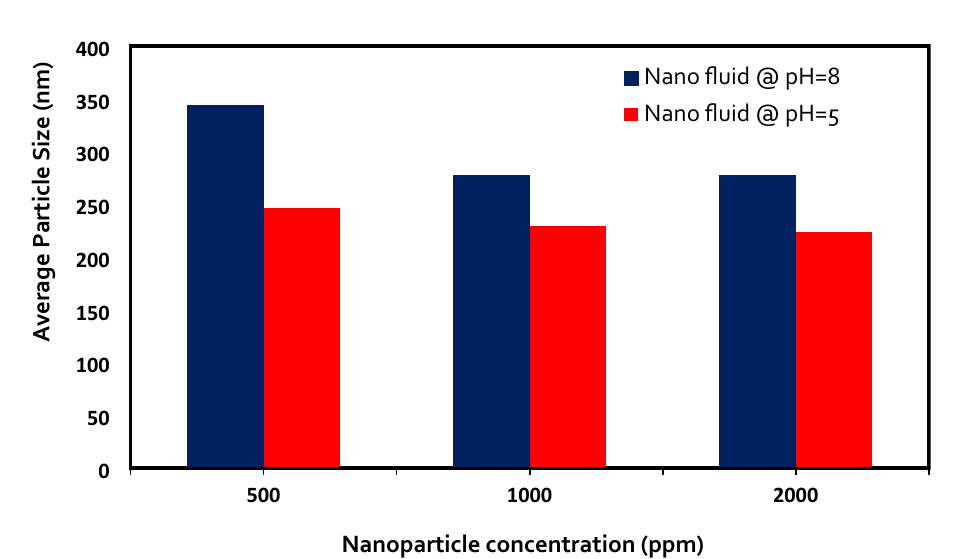
Figure 7. Average particle size vs. NPs concentration with various pH.